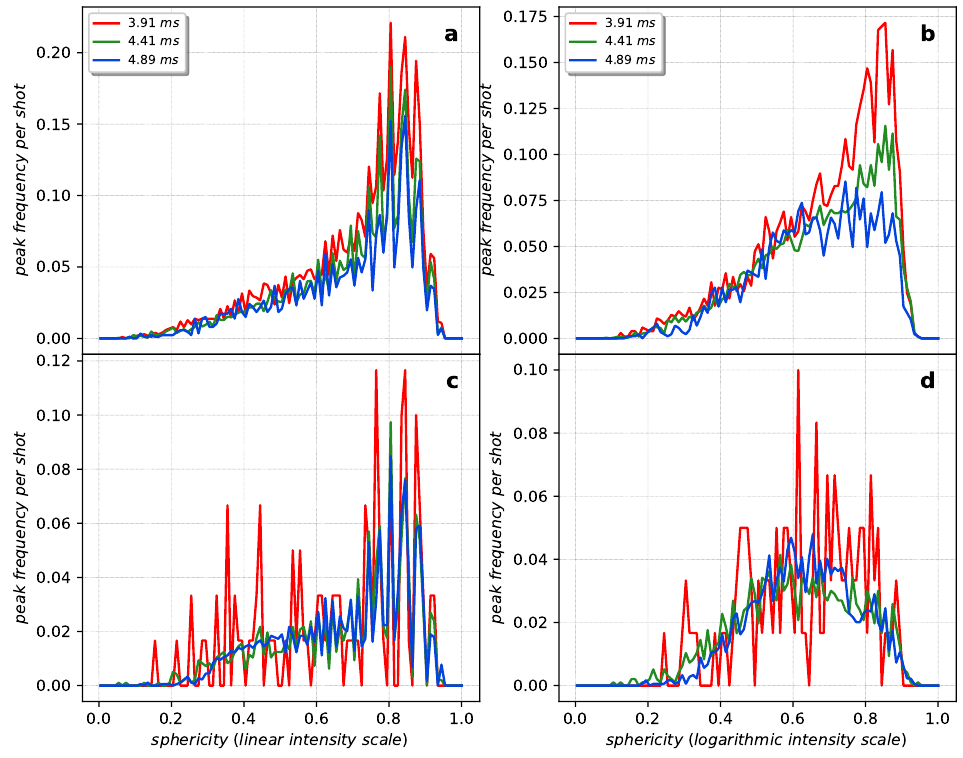
Figure 5. Frequency of a peak appearing with a certain sphericity in a Q -range of 1.5 to 2 Å − 1 for the strong hits above 50 ADU/pixel in ( a ) linear and ( b ) logarithmic intensity scales as well as for the weak hits below 50 ADU/pixel in ( c ) linear and ( d ) logarithmic intensity